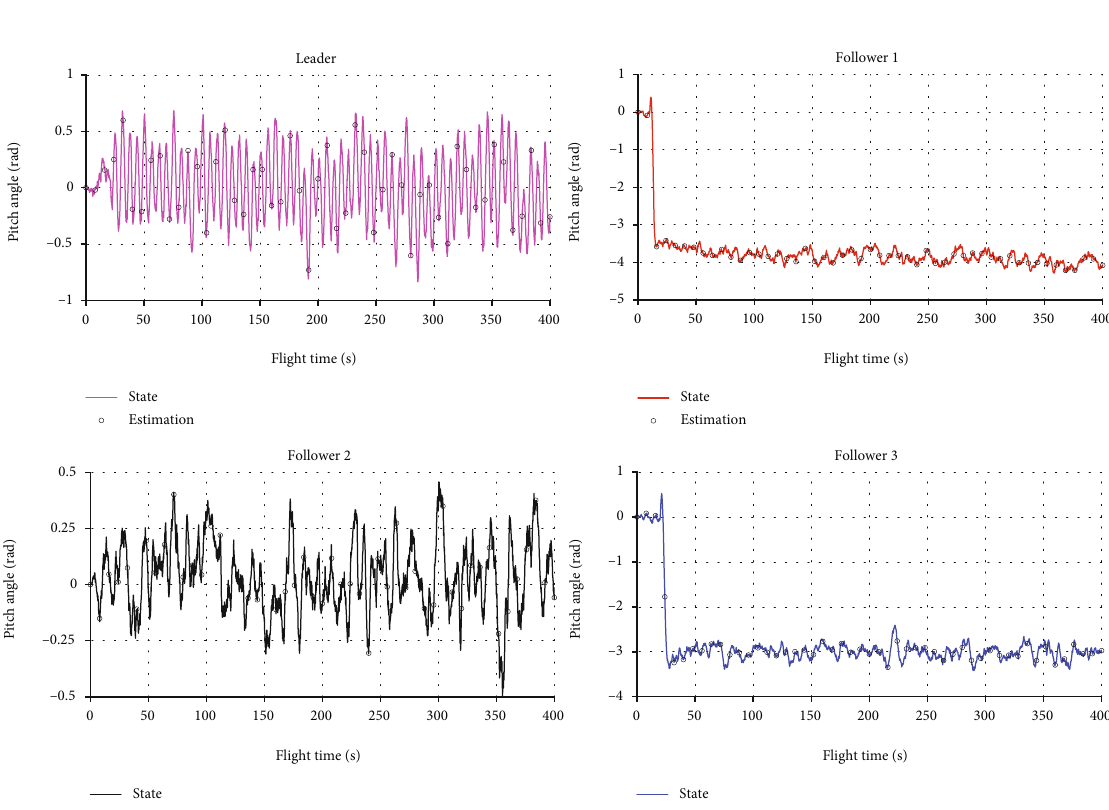
Figure 12: The system pitch angle and